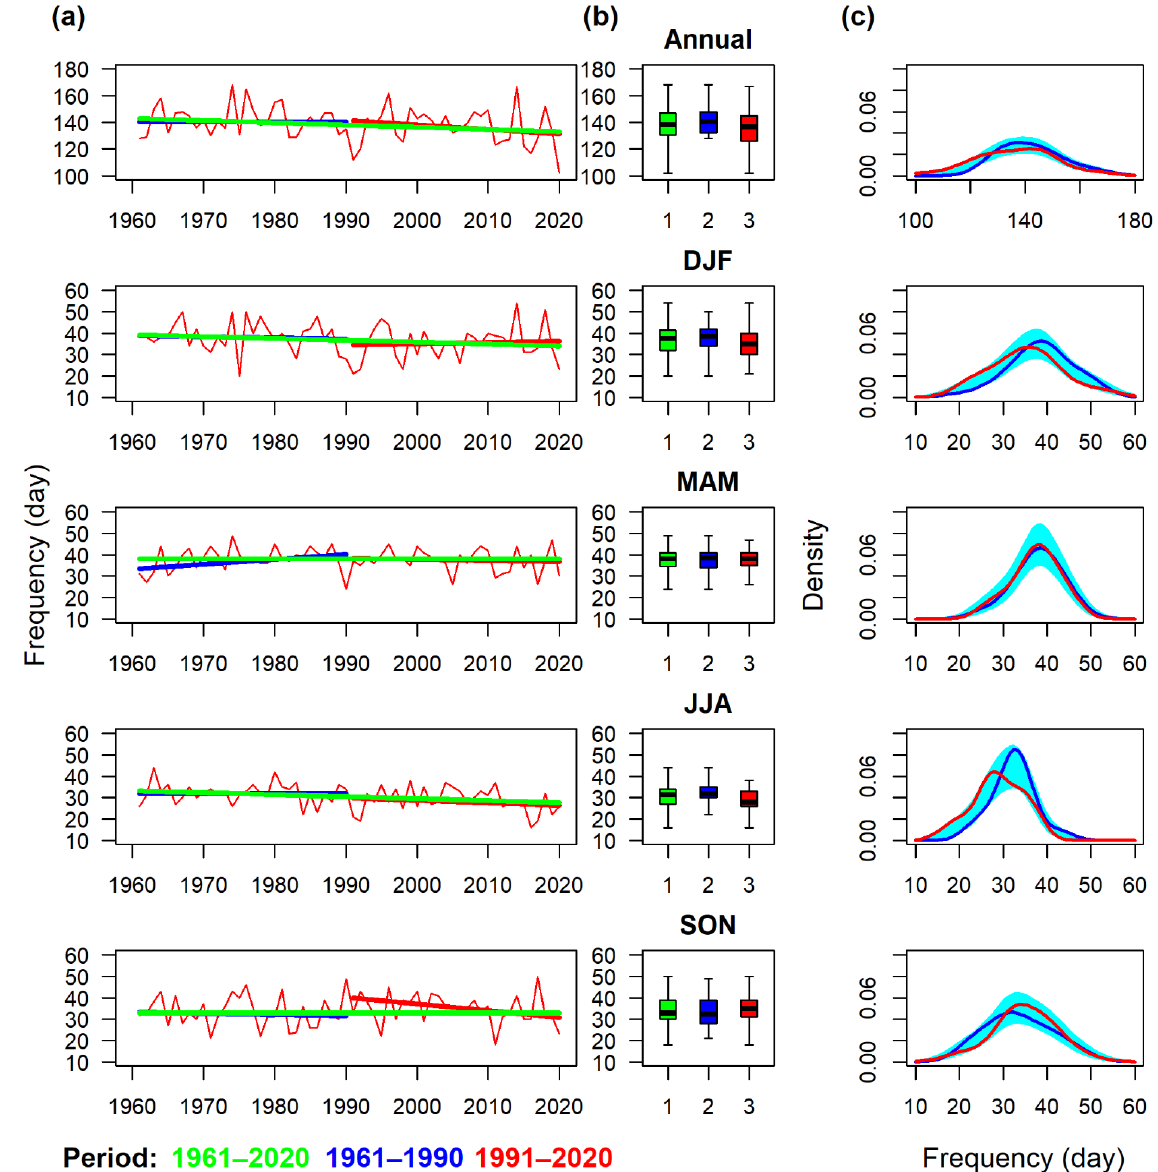
Figure 4. Annual and seasonal frequencies of days with directional circulation types according to the objective classification for the territory of the Czech Republic in the 1961 – 2020 period: ( a ) fluc- objective classification for the territory of the Czech Republic in the 1961–2020 period: ( a ) fluctuations tuations with linear trends in the entire period, 1961 – 1990 and 1991 – 2020; ( b ) box plots (median, with linear trends in the entire period, 1961–1990 and 1991–2020; ( b ) box plots (median, lower and lower and upper quartile, minimum, and maximum) for 1961 – 2020 (1), 1961 – 1990 (2), and 1991 – 2020 (3); ( c ) the density distribution of the series in 1961 – 1990 and 1991 – 2020. The density curves upper quartile, minimum, and maximum) for 1961–2020 (1), 1961–1990 (2), and 1991–2020 (3); ( c ) the outside the reference band (green – blue) indicate a significant difference in the two distributions density distribution of the series in 1961–1990 and 1991–2020. The density curves outside the reference (and vice versa). band (green–blue) indicate a significant difference in the two distributions (and vice